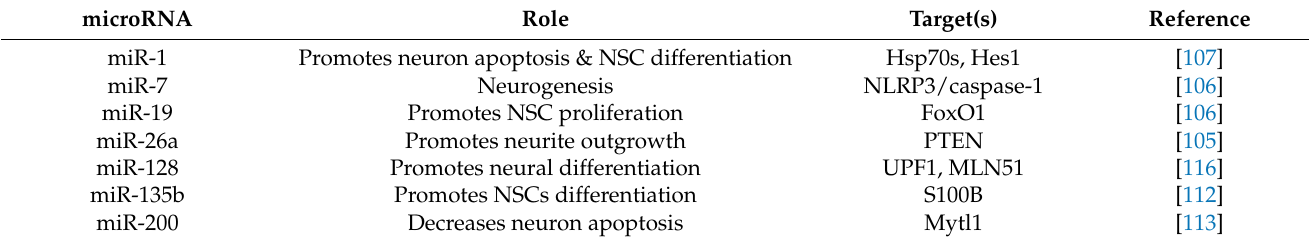
Table 3. MicroRNAs in neural stem cells and neurogenesis *.